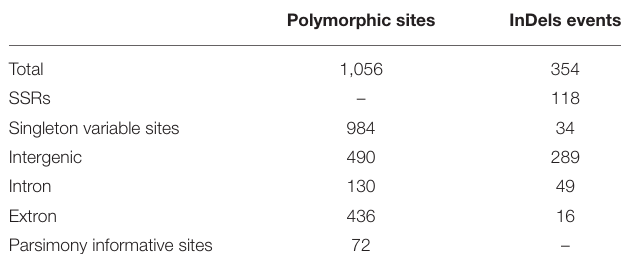
TABLE 2 | Summary statistics for variable sites and insertion or deletion (InDel) mutations of the five Kalanchoe